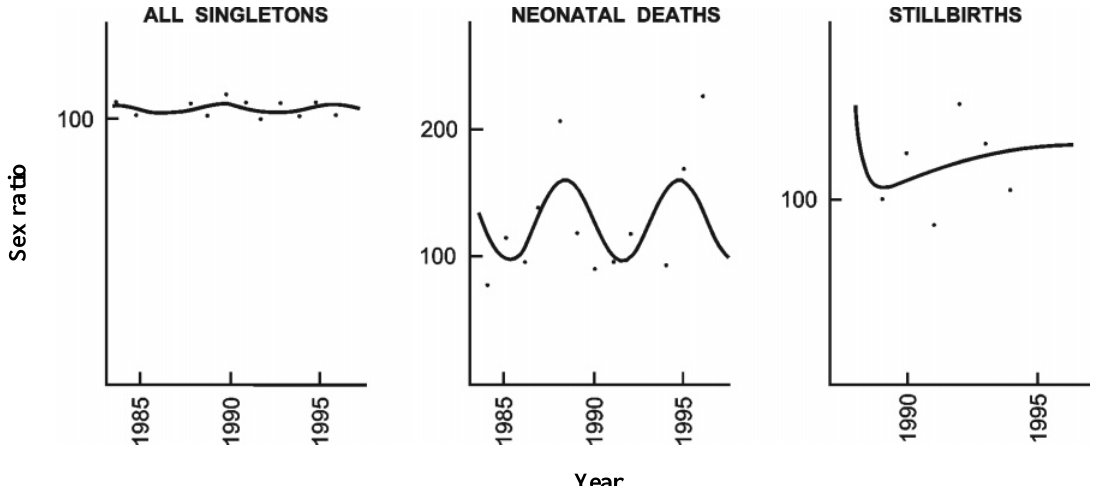
Figure 5 - Best fit regression curves for the annual sex ratio distribution of all newborn singletons [ y = 104.260 + 1.450 sin ( year + 1.145)], of those who died in the first week [ y = 129.450 - 31.596 sin ( year - 0.765)] and of stillborn singletons ( y = 145.886 - 165.247 + 172.948). The curves for all singletons and for those who died in the first week refer to the period from 1984 to 1996, while the curve for stillbirths refers to the period from 1988 to 1996.